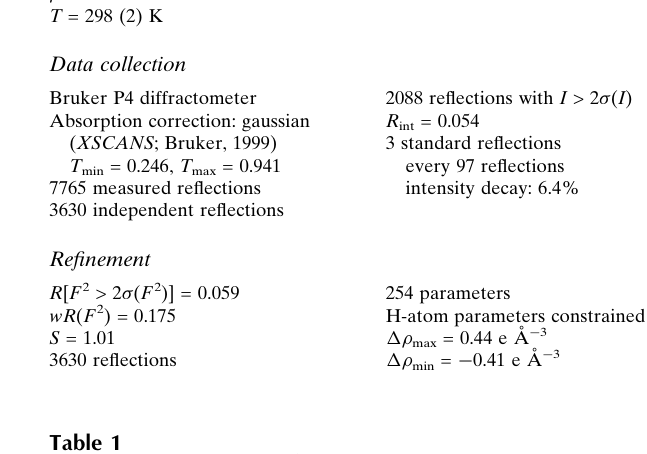
Hydrogen-bond geometry (A˚ , (cid:1) ).